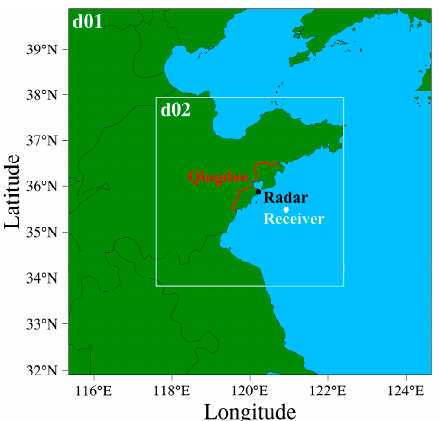
Figure 8. The domain configuration in the numerical estimation.